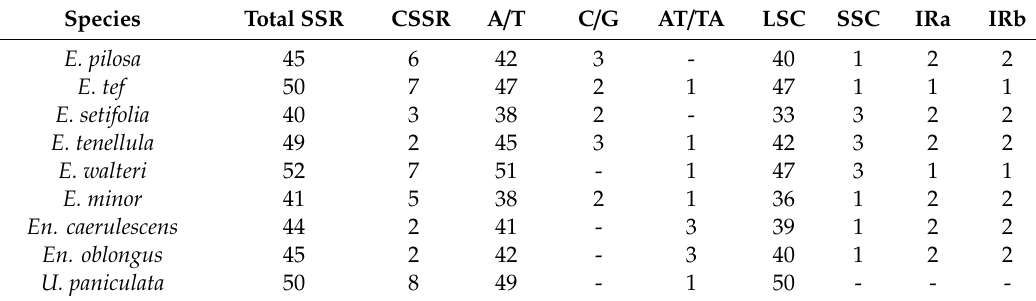
Table 3. SSR distribution among Eragrostideae cp genomes. CSSR; compound SSR. Species Total